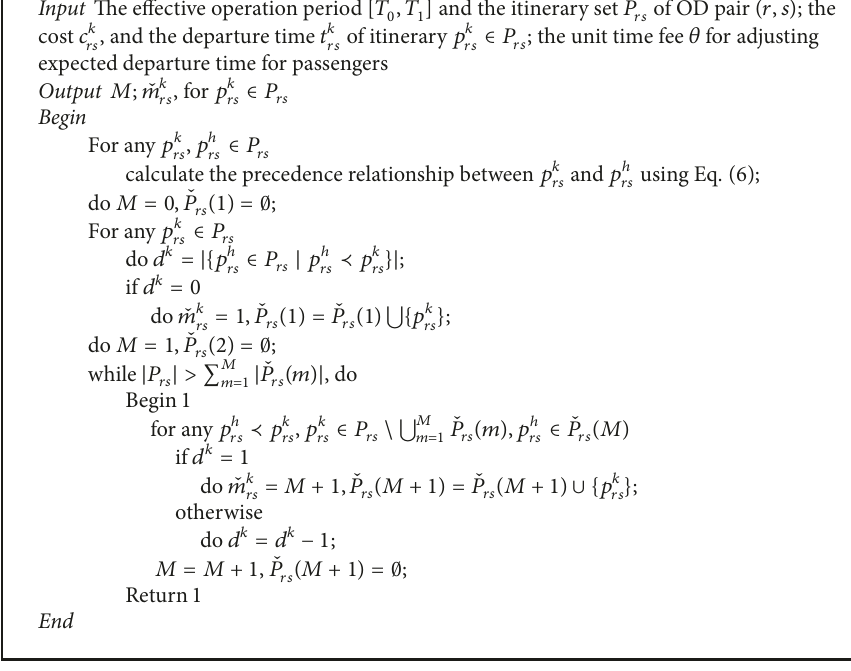
Algorithm 1: The First Booking Phase Partition